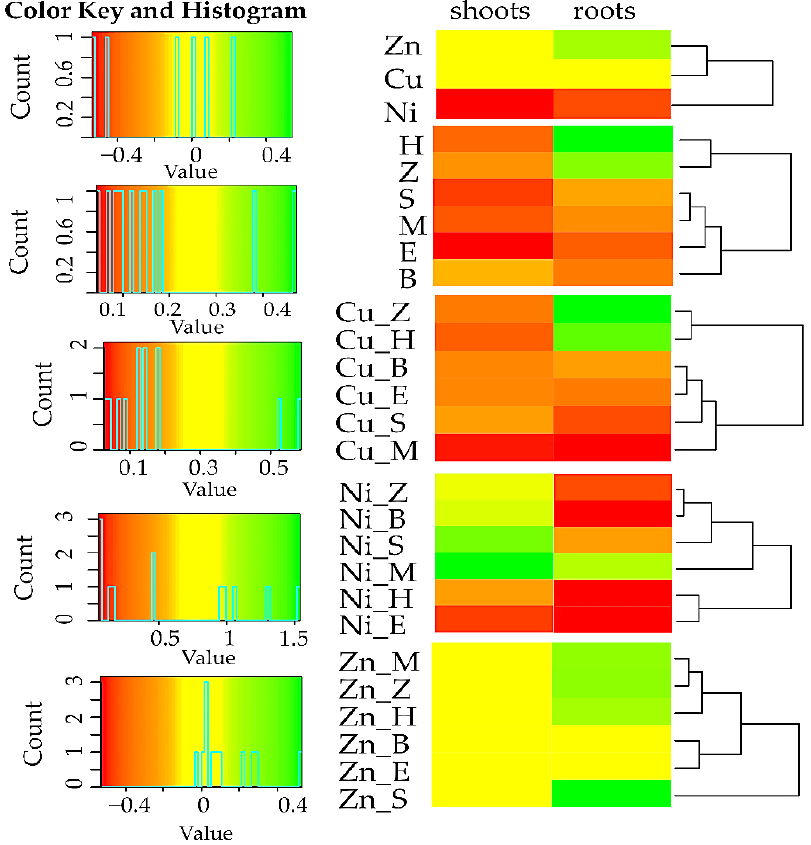
Figure 5. Index of the influence of sorbents on the d.m. yield aerial parts of Helianthus annuus L. The abbreviations are explained under Figure 1.